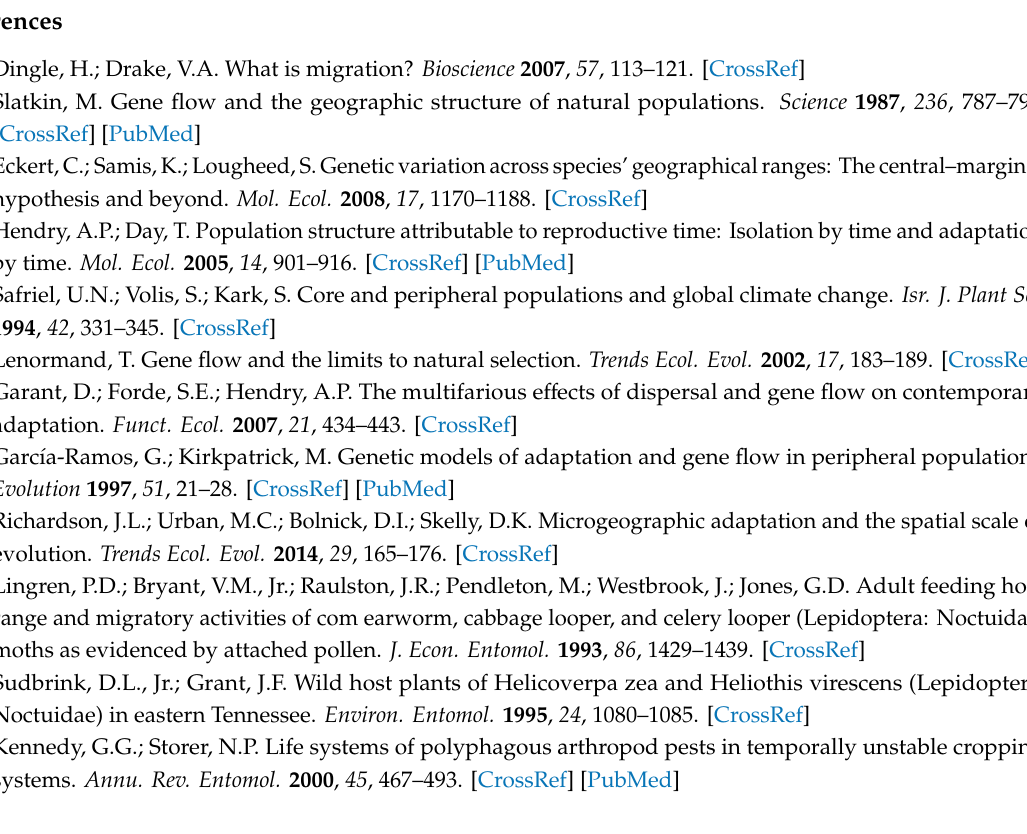
Table S2; Genotype data for all loci for all insects from putative populations obtained for H. zea population genetics study, Table S3; Genotype data for 85 loci for 702 H. zea used in population genetics study, Table S4; Mean and locus-by-locus observed and expected heterozygosities for putative populations, Tables 5a and 5b; Total number and mean of transitions, transversions, substitutions, private substitution sites, and the molecular diversity for 16 putative H. zea populations, Table S6; Locus by locus exacts tests for Hardy–Weinberg equilibrium, Table S7; Exact test (global) p -values for sample di ff erentiation based on genotype frequencies, Table S8; Pairwise F ST value estimates and significant( p ≤ 0.01) F ST values for H. zea populations collected from Landisville and Rock Springs, PA, Table S9; Nei’s genetic distance (d) and the allelic di ff erences between pairs of H. zea populations and the number of di ff erences within each population, Table S10; The number of loci linked with 85 loci in putative H. zea populations, Table